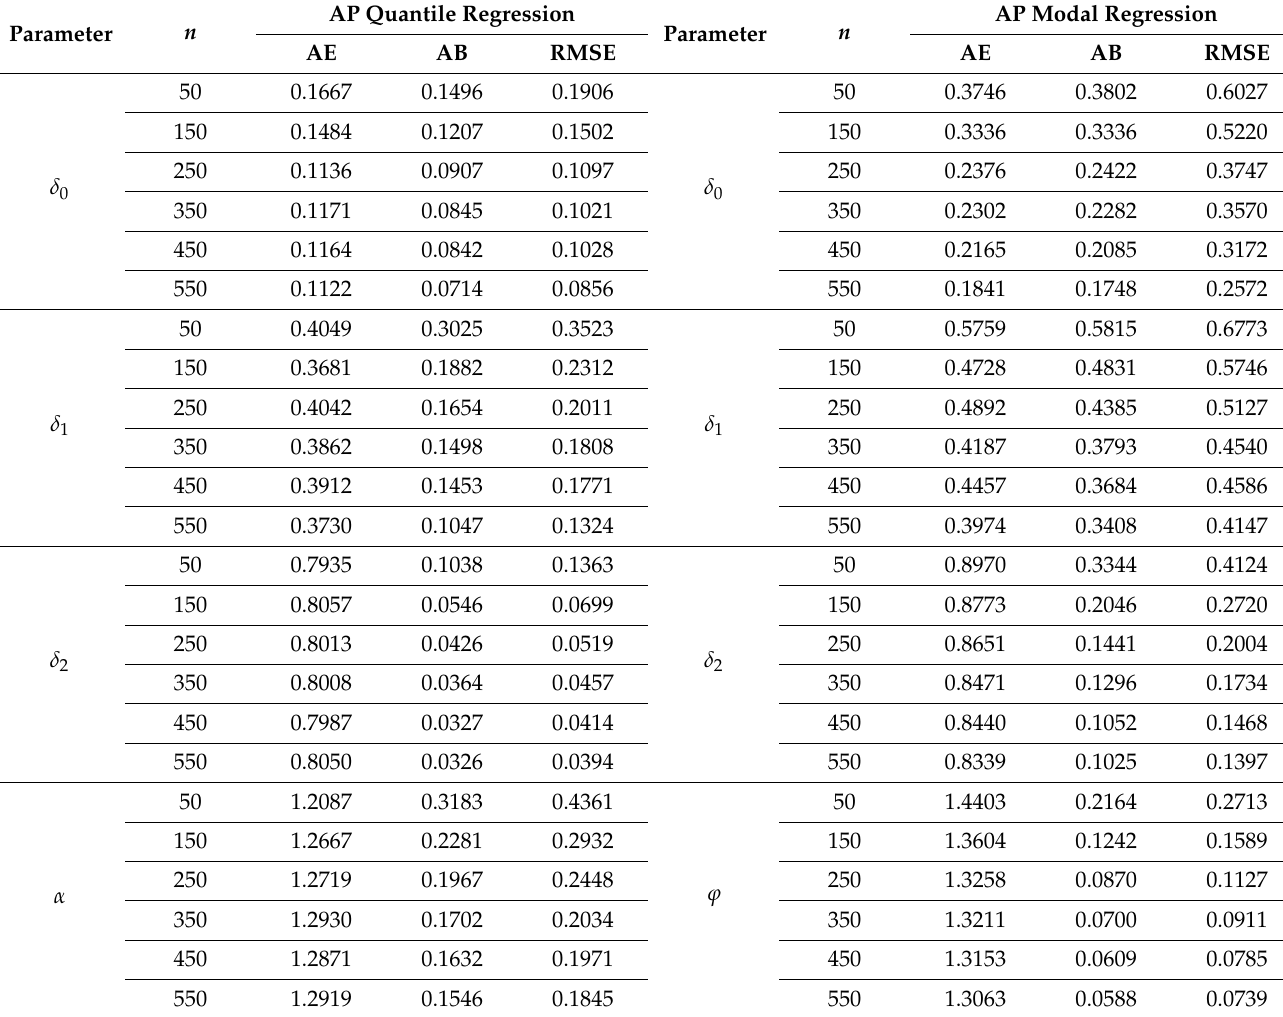
Table 6. Simulation results for the second scenario.